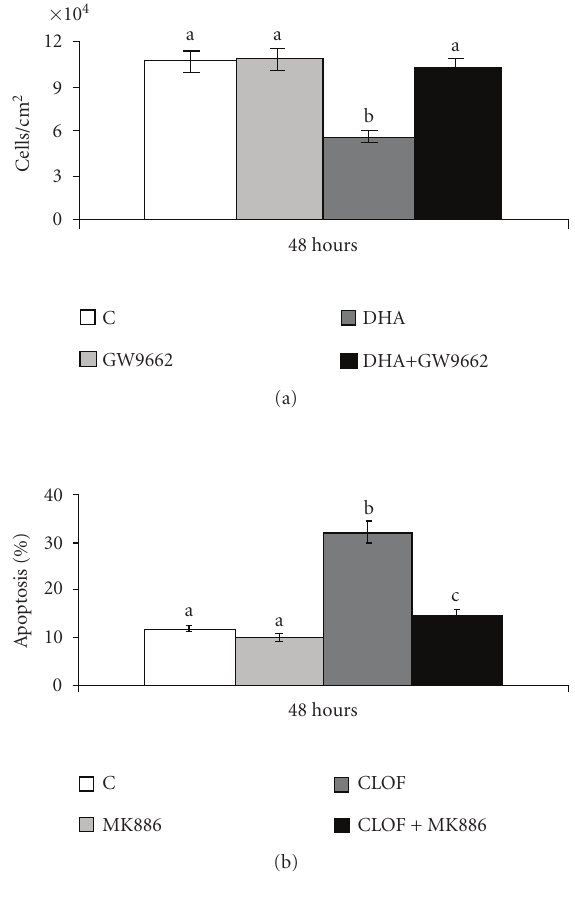
Figure 6: Cell growth and apoptosis, respectively, in A549 and NCTC 2544 cells after treatment with antagonist and ligand of PPARs. (a) Cell growth in A549 cells: 24 hours after seeding, cells were treated with 50 μ M of DHA and/or 10 μ M GW9662 for a fur- ther 48 hours. Control cells were treated with vehicle alone. The number of cells/cm 2 counted in the monolayer is represented as mean ± SD of 3 experiments. (b) Apoptosis in NCTC 2544 cells: 24 hours after seeding, cells were treated with 250 μ M clofibrate (CLOF) and/or 5 μ M MK886 for a further 48 hours. Control cells were treated with vehicle alone. Apoptosis was determined by flow cytometric analysis. The percentages of apoptotic cells are presented as means ± SD of 3 experiments. Means with di ff erent letters are significantly di ff erent from one another ( P < . 05) as determined by analysis of variance followed by post hoc Newman-Keuls